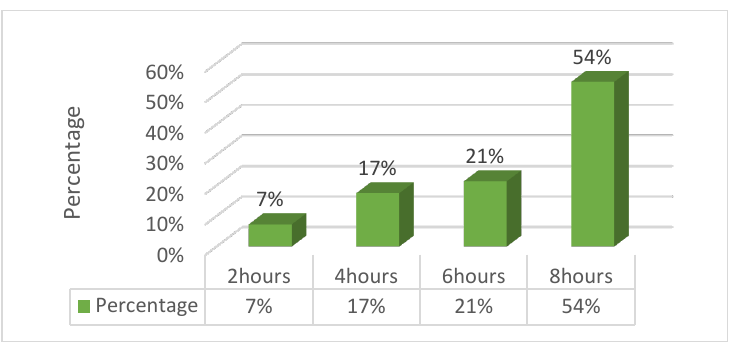
Fig. 2. Number of hours respondents work each day.